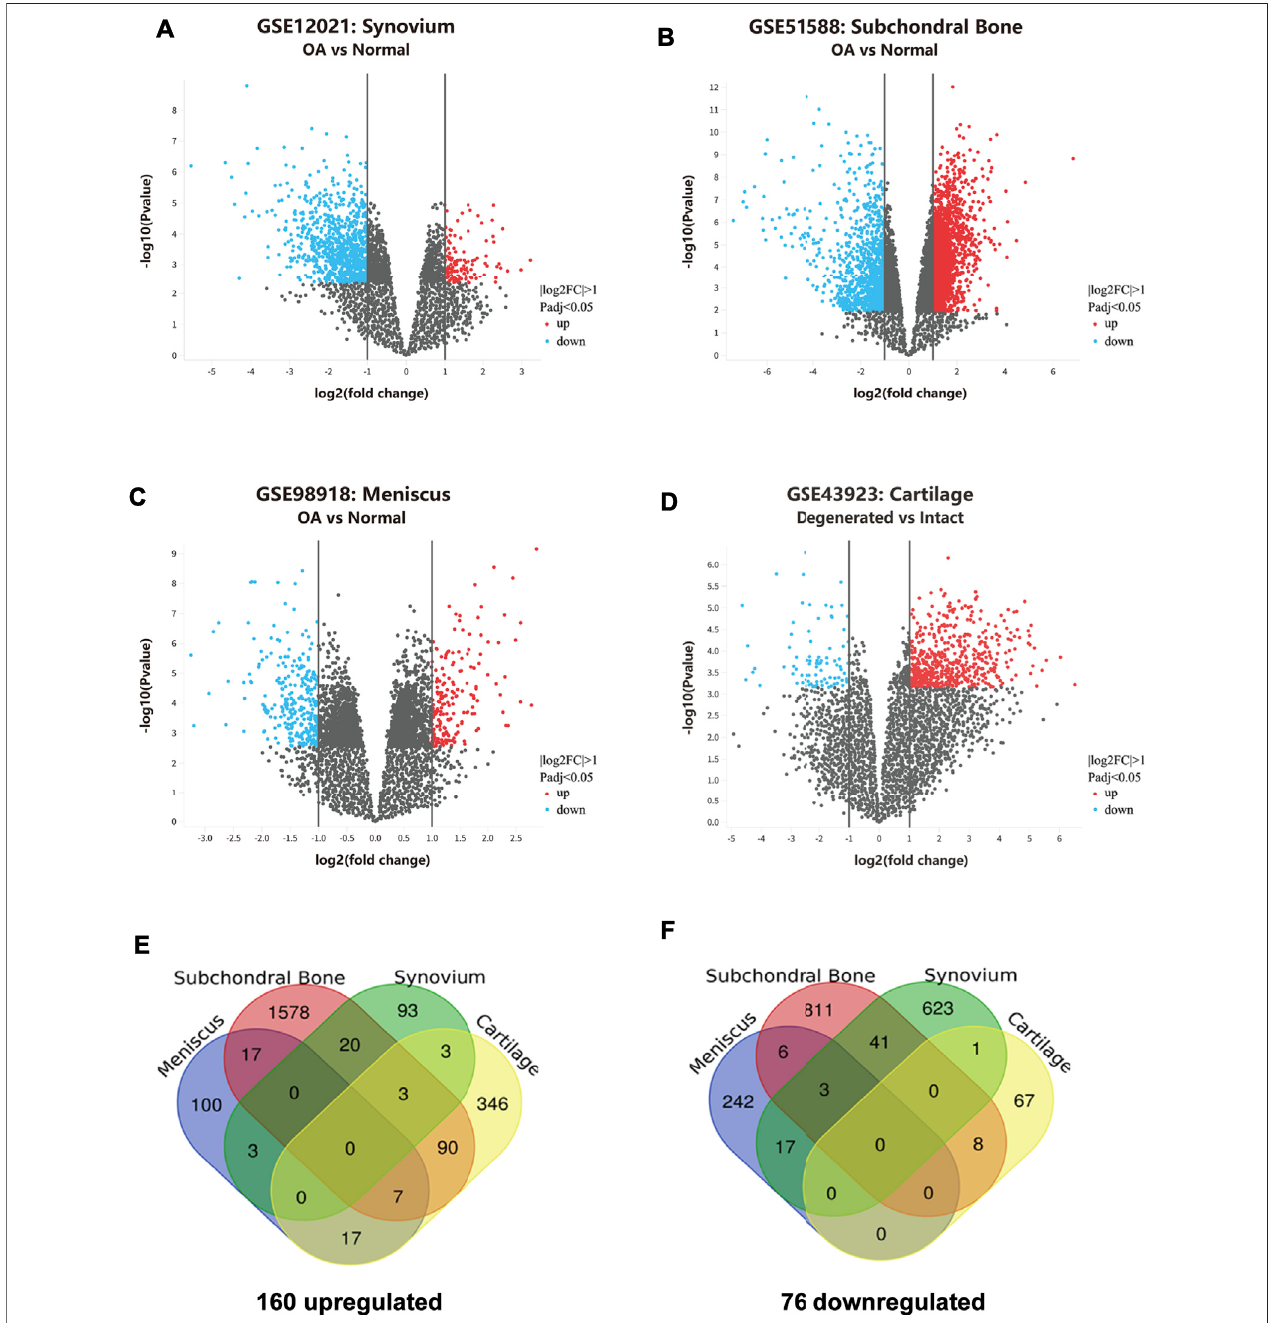
Table 3 . MYC, VEGFA, IL2RB, MAPK14, IL6R, MMP9, HLA- DQB1, and CXCL12 were most enriched in these identi fi ed KEGG